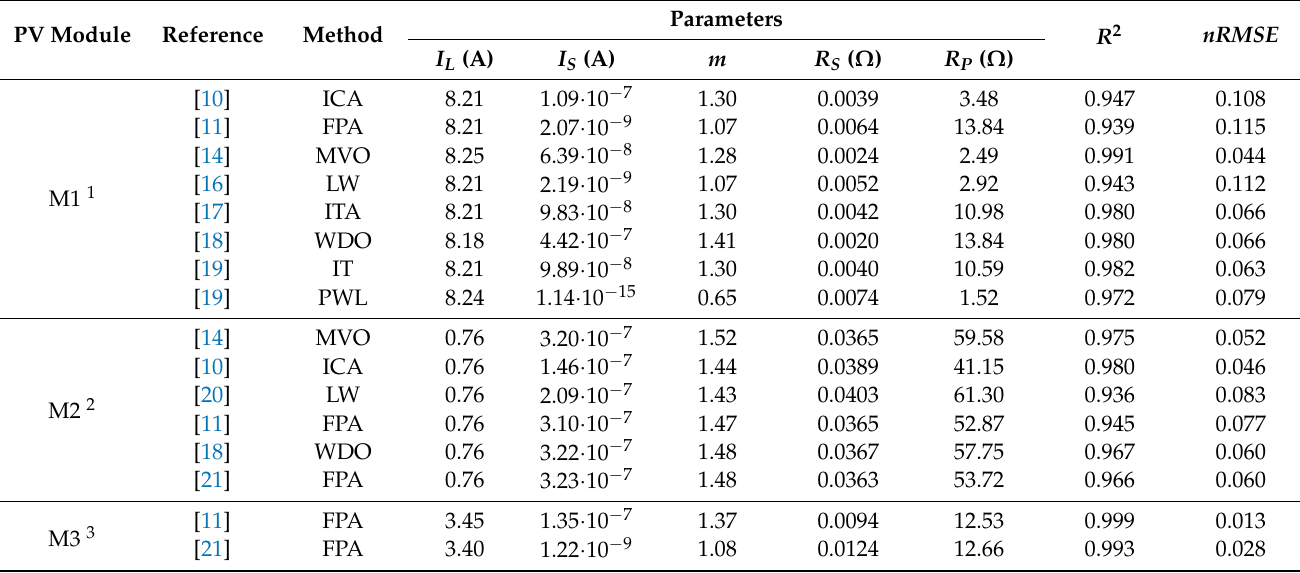
Table 1. The one-diode model parameters and the replication performance of the experimental I-V characteristics, reported by different studies for three commercial PV modules at